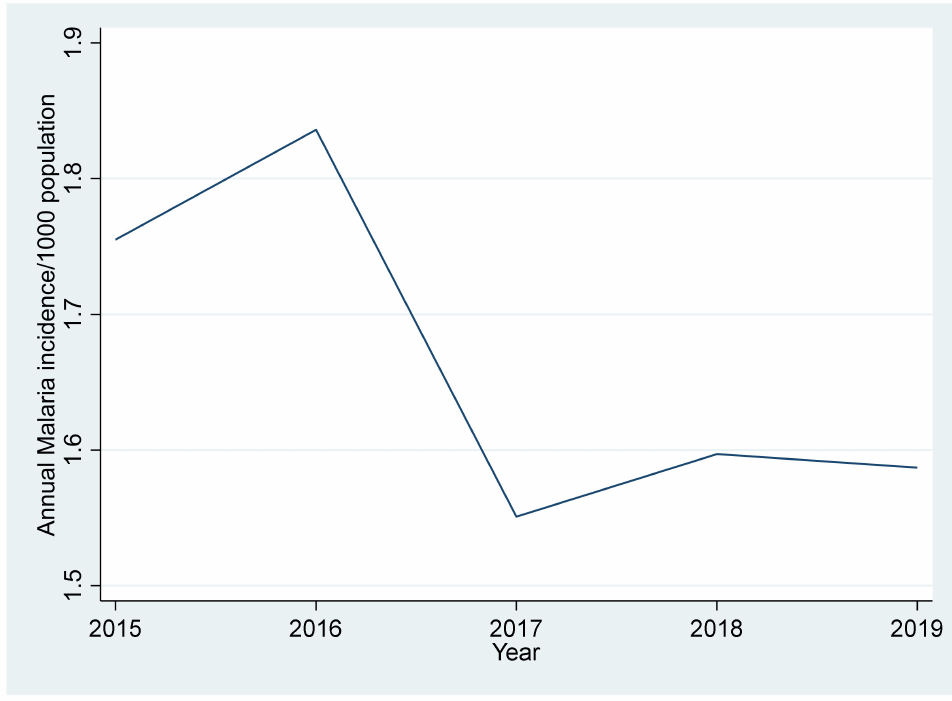
Figure 2. Trends of annual incidence of Malaria per 1000